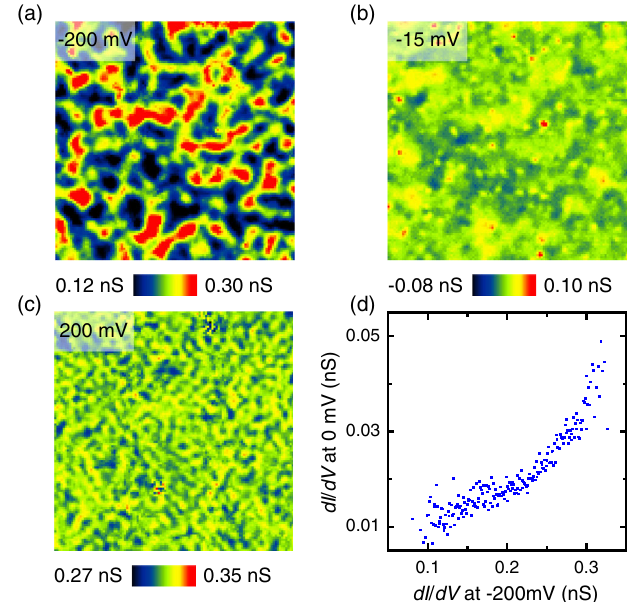
FIG. 4. (a) – (c) dI=dV maps obtained in the same field of view as in Fig. 3(a) with bias voltages − 200 , − 15 , and 200 mV respectively. (d) Cross-correlation plot of the − 200 mV (a) and − 15 mV (b) dI=dV maps, demonstrating a clear positive